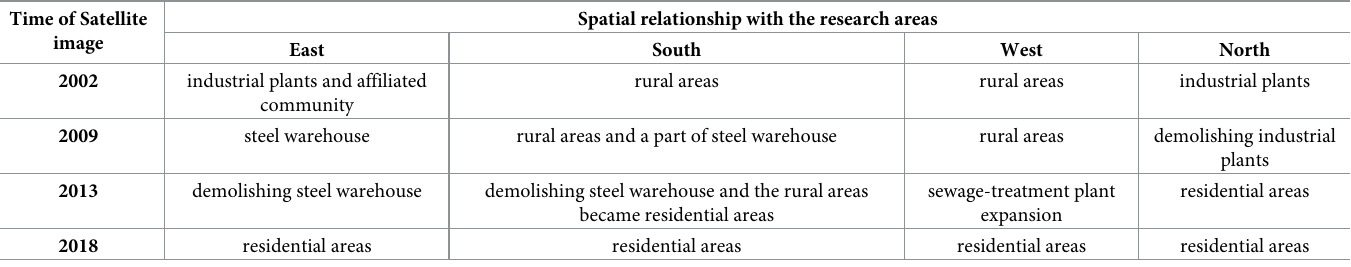
Table 8. Land use changes from 2002 to 2018 around the